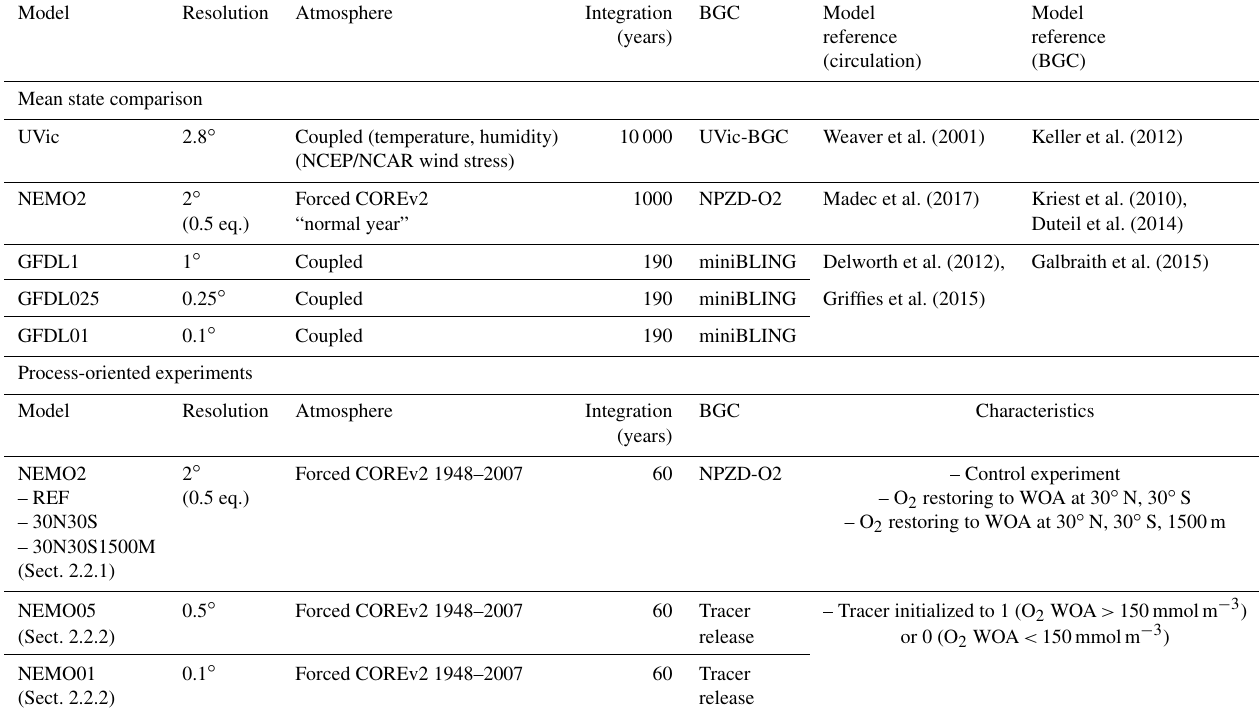
Table 1. Main characteristics of the models and experiments analyzed in this